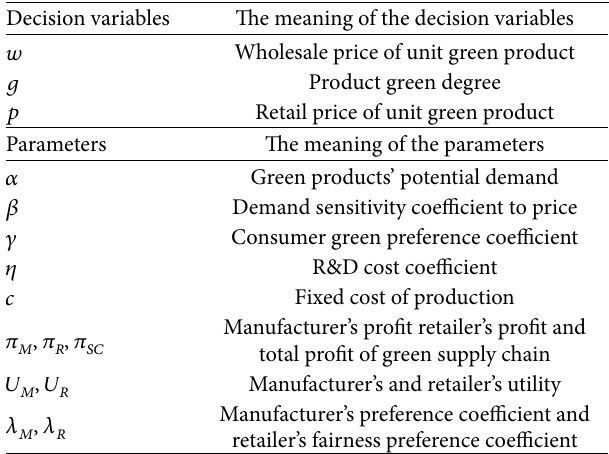
Table 2: Decision variables and major parameters. Decision